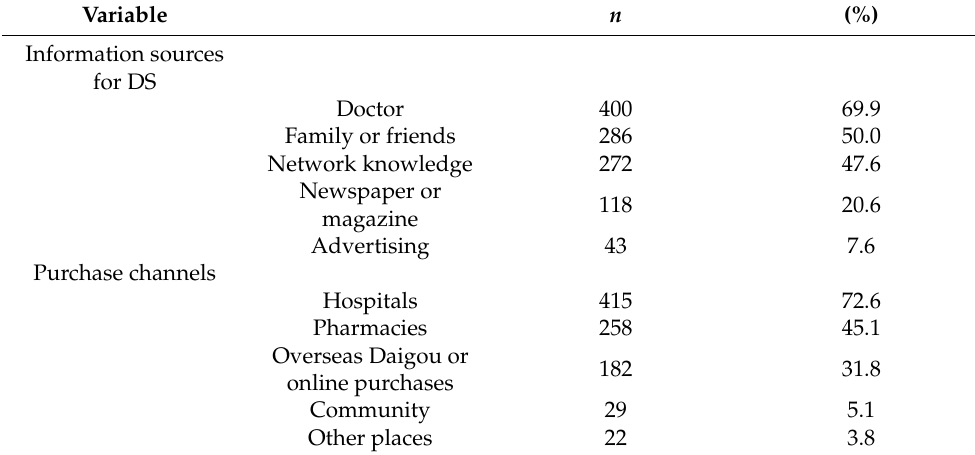
Table 2. Information sources and purchase channels of dietary supplements.